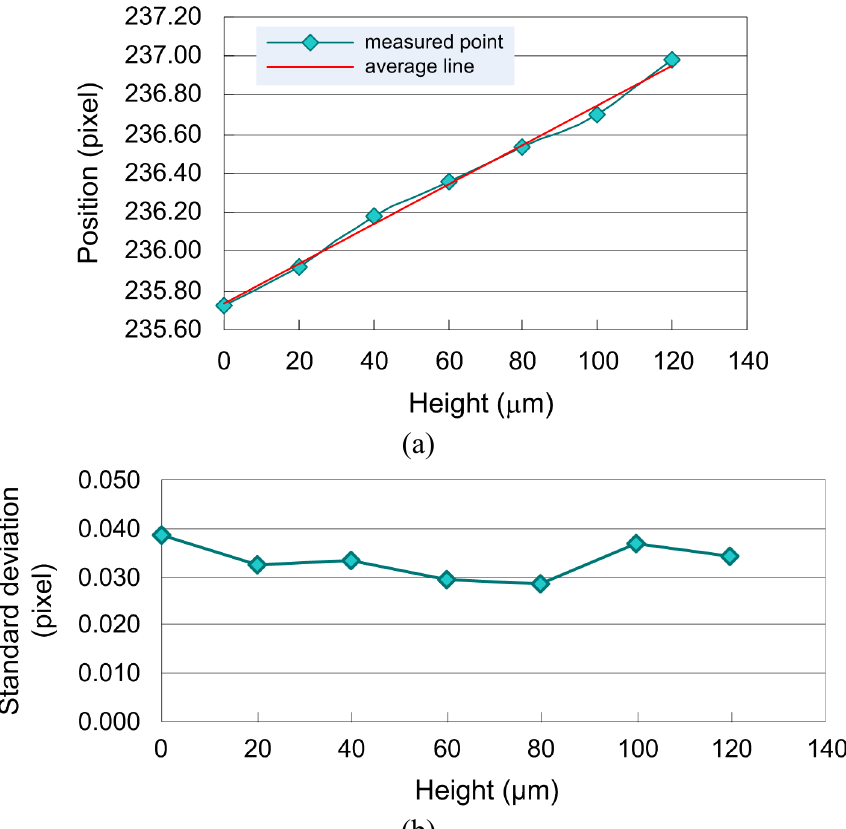
Figure 6. Calibration for the pulsation amplitude measurement of the proposed APM system: (a) the results for linearity calibration experiments and (b) the one standard deviation of amplitude calibration